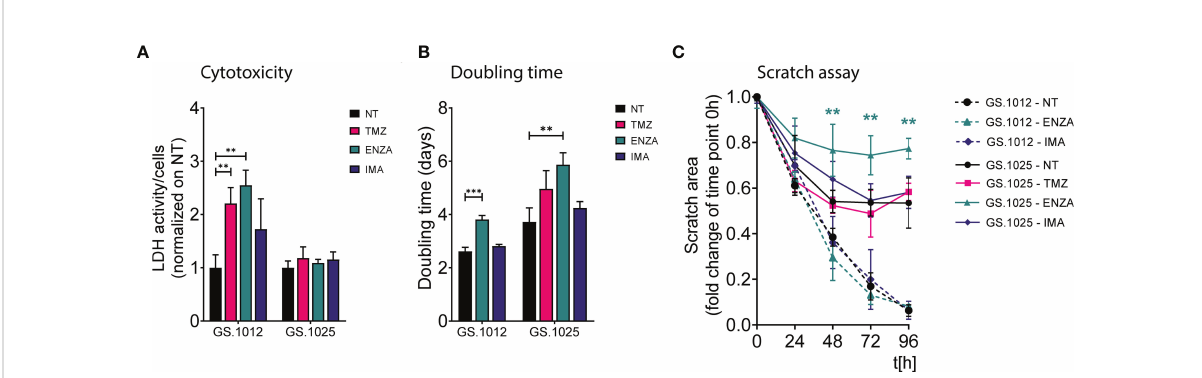
FIGURE 1 LDH activity, proliferation, and migration assay of GS.1012 and GS.1025 2D cell cultures. (A) Bar plots show the LDH activity in samples GS.1012 and GS.1025 for temozolomide (TMZ), enzastaurin (ENZA) and imatinib (IMA) treated samples normalized to values observed in untreated (NT) condition. (B) Bar plots show the cell proliferation expressed as doubling time in days, of GS.1012 and GS.1025 in untreated (NT), temozolomide (TMZ), enzastaurin (ENZA) and imatinib (IMA) conditions. (C) Line plots show the percentage of the scratched area (normalized to values observed at t=0h) across time (hours). Continuous lines represent GS.1012, while segmented line represents GS.1025. Data are presented as mean (n=3) ± SD. **p < 0.01; ***p <